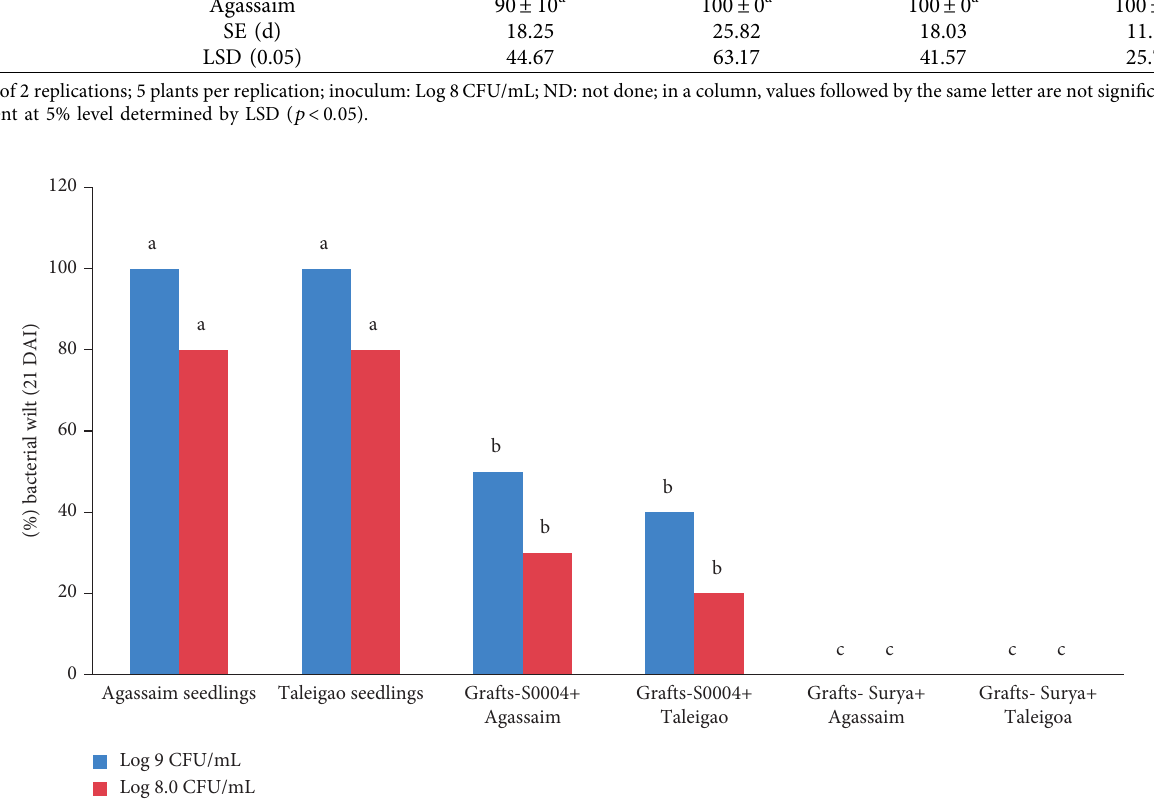
Table 1: Incidence of wilt in the rootstock lines, local cultivars/varieties inoculated with R. pseudosolanacearum . S. No.